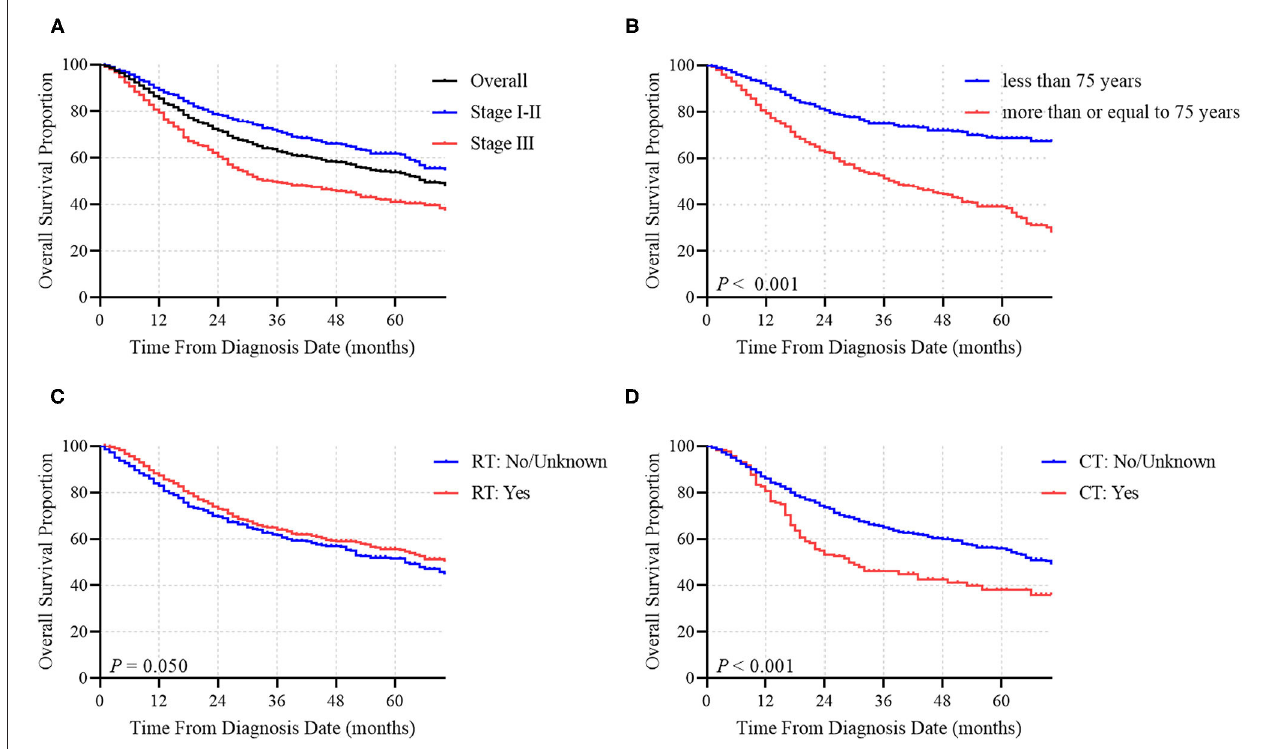
FIGURE 3 | OS of MCC patients according to (A) tumor stage, (B) age at diagnosis, (C) RT or (D) CT.